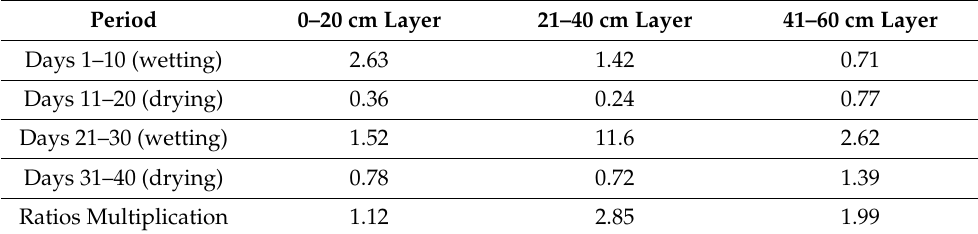
Table 2. The absolute error ratio of the parameter α between the end and the beginning of the drying and wetting periods using